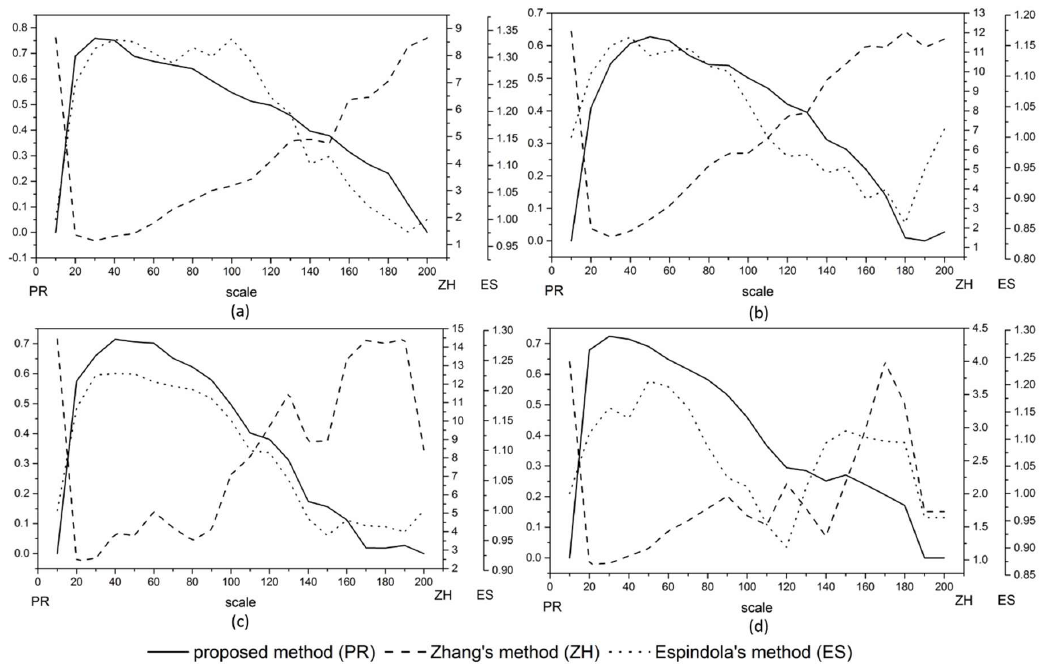
Figure 14. The UE results of the segmentations produced by the MRS method with different UE methods, using the SZTAKI-INRIA building detection dataset: ( a ) Bodensee, ( b ) Cot d’Azur, ( c ) Manchester, and ( d ) Szada.